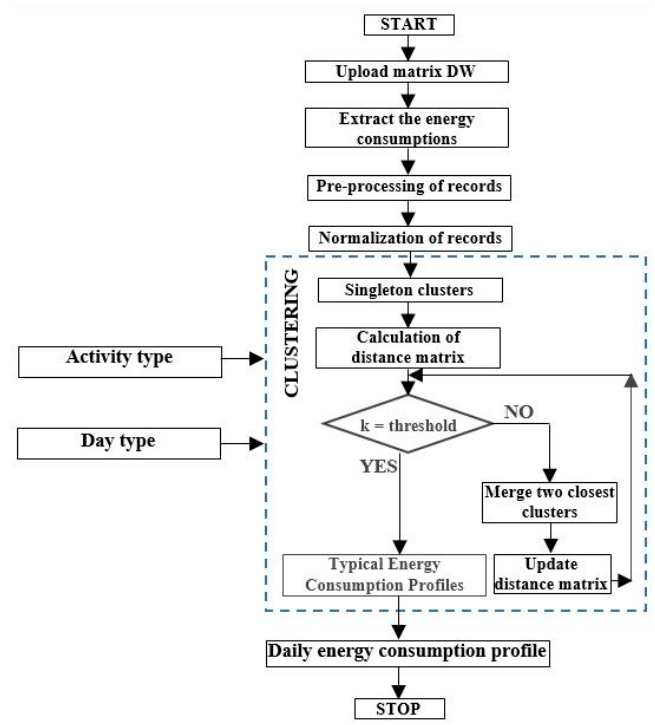
Figure 6. The steps completed to obtain the typical energy consumption profiles (TECPs).